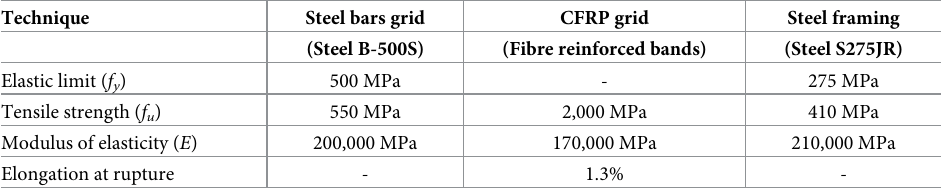
Table 2. Mechanical properties of the retrofitting materials